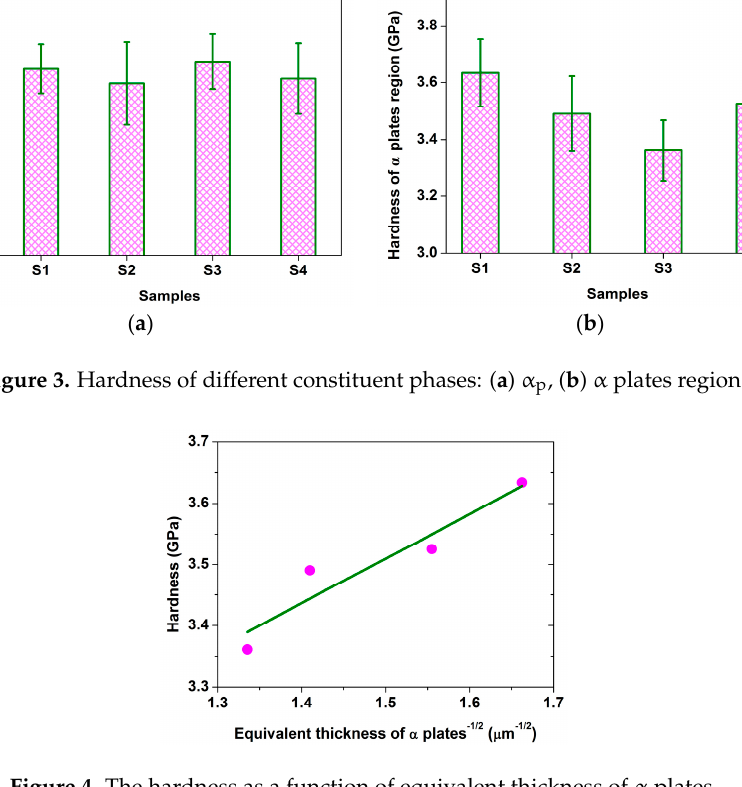
Figure 4. The hardness as a function of equivalent thickness of α plates.